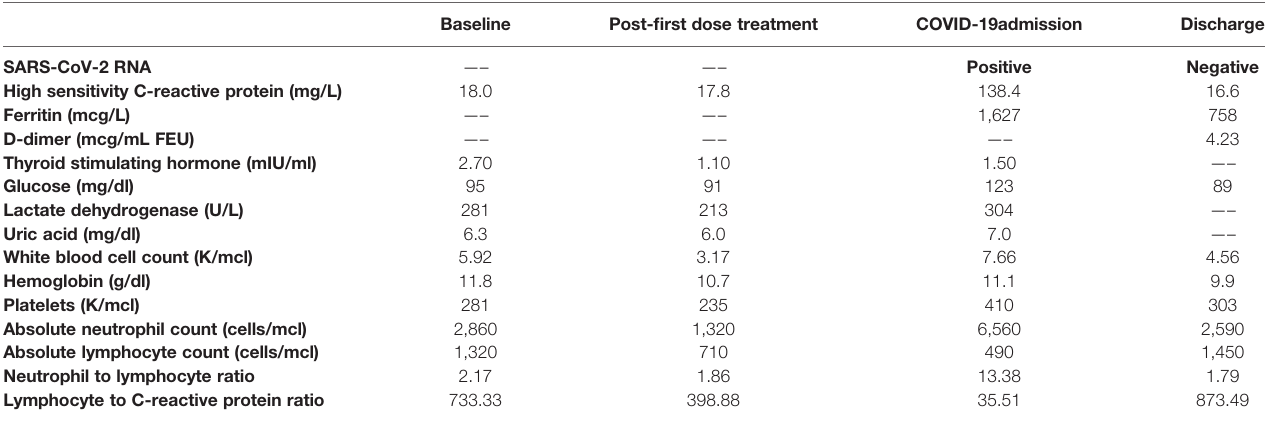
TABLE 1 | Relevant laboratory